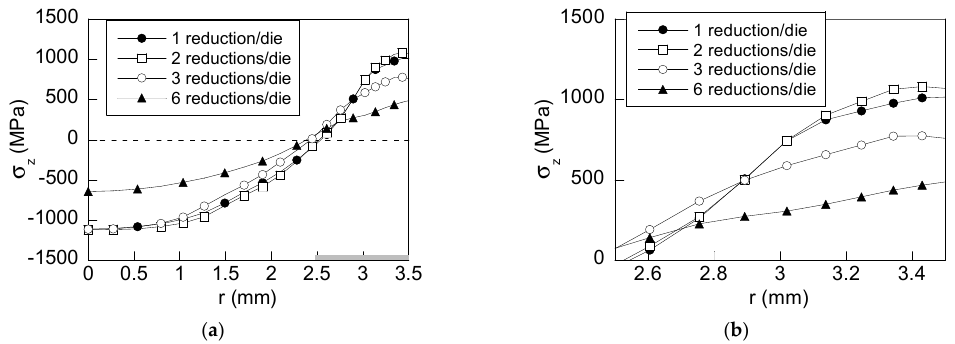
Figure 4. Radial distribution of axial stress: ( a ) general view; ( b ) detailed view of the important near-surface region of the wire.